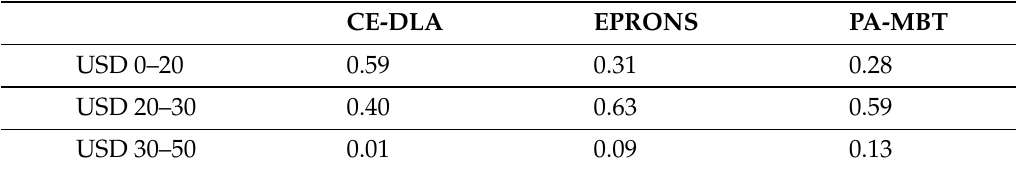
Figure 6. Cost-to-Performance of ( a ) DL training and ( b ) inference jobs. Table 2. The ratio of DL training job allocation on 3 pricing ranges [USD 0–20], [USD 20–30], and [USD 30–50].